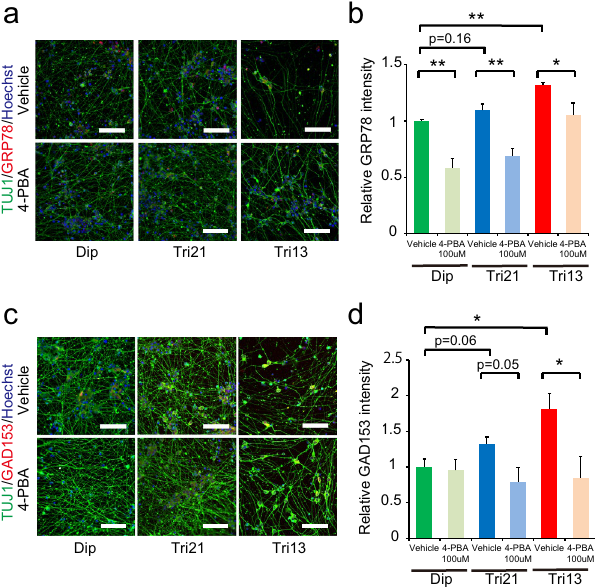
Figure 5. Elevated ER stress in trisomic neurons, which was ameliorated by 4-phenylbutyric acid. ( a ) Representative images showing immunocytochemical staining for GRP78 (BIP) (red) and TUJ1 (green) in diploid and trisomic NGN2-neurons treated with vehicle or 4-PBA. Hoechst 33342 (blue), counterstaining. Scale bar = 200 μm. ( b ) Quantification of the relative intensity of GRP78 (BIP) in NGN2-neurons treated with vehicle or 4-PBA. Data are presented as mean ± SEM normalized to the average of diploid clones. * P < 0.05, n = 4 per clone. ( c ) Representative images showing immunocytochemical staining for GAD154 (CHOP) (red) and TUJ1 (green) in diploid and trisomic NGN2-neurons treated with vehicle or 4-PBA. Hoechst 33342 (blue), counterstaining. Scale bar = 200 μm. ( d ) Quantification of the relative intensity of GAD153 (CHOP) in NGN2- neurons treated with vehicle or 4-PBA. Data are presented as mean ± SEM normalized to the average of diploid clones. * P < 0.05, n = 4 per